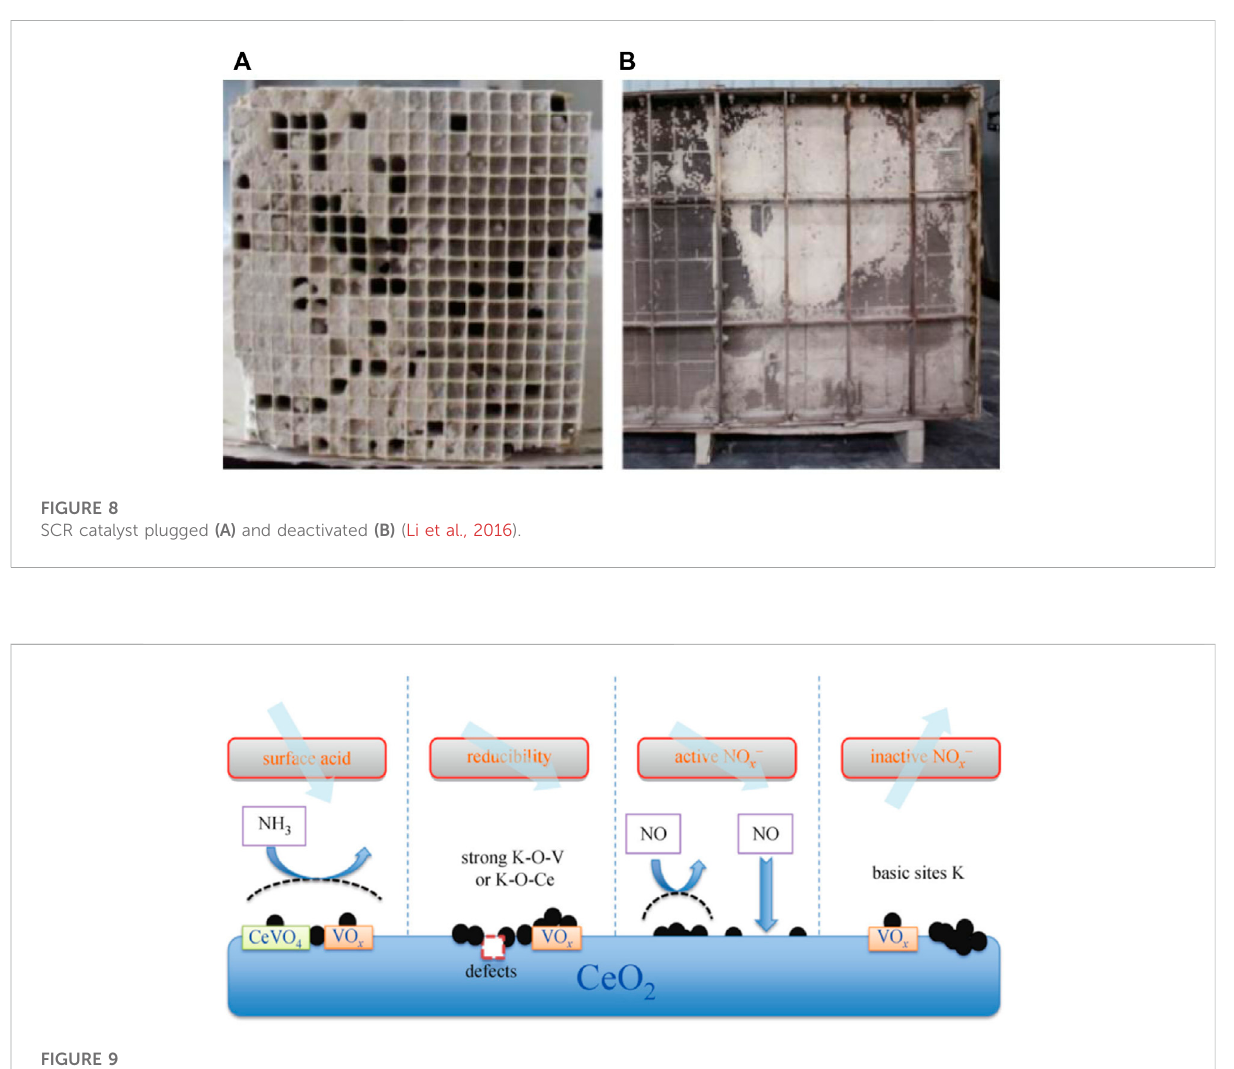
FIGURE 9 K 2 O poisoning mechanism on CeO 2 surface (Li et al.,